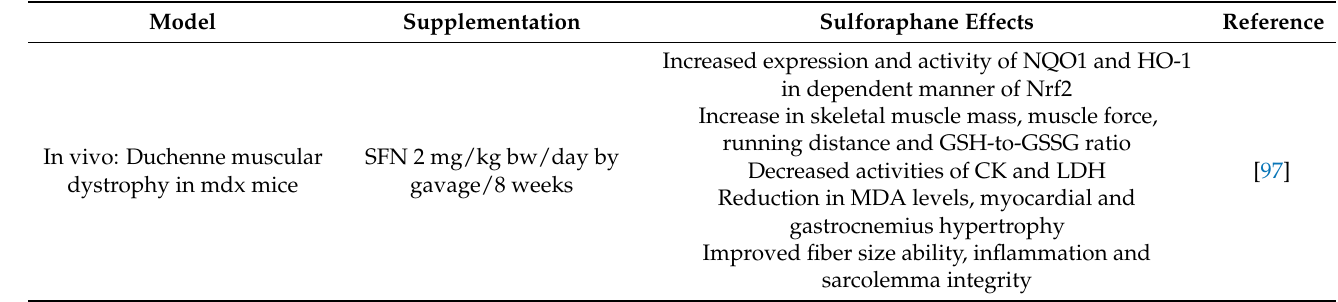
Table 2. Studies evaluating the effect of sulforaphane in several models of muscle disorders and